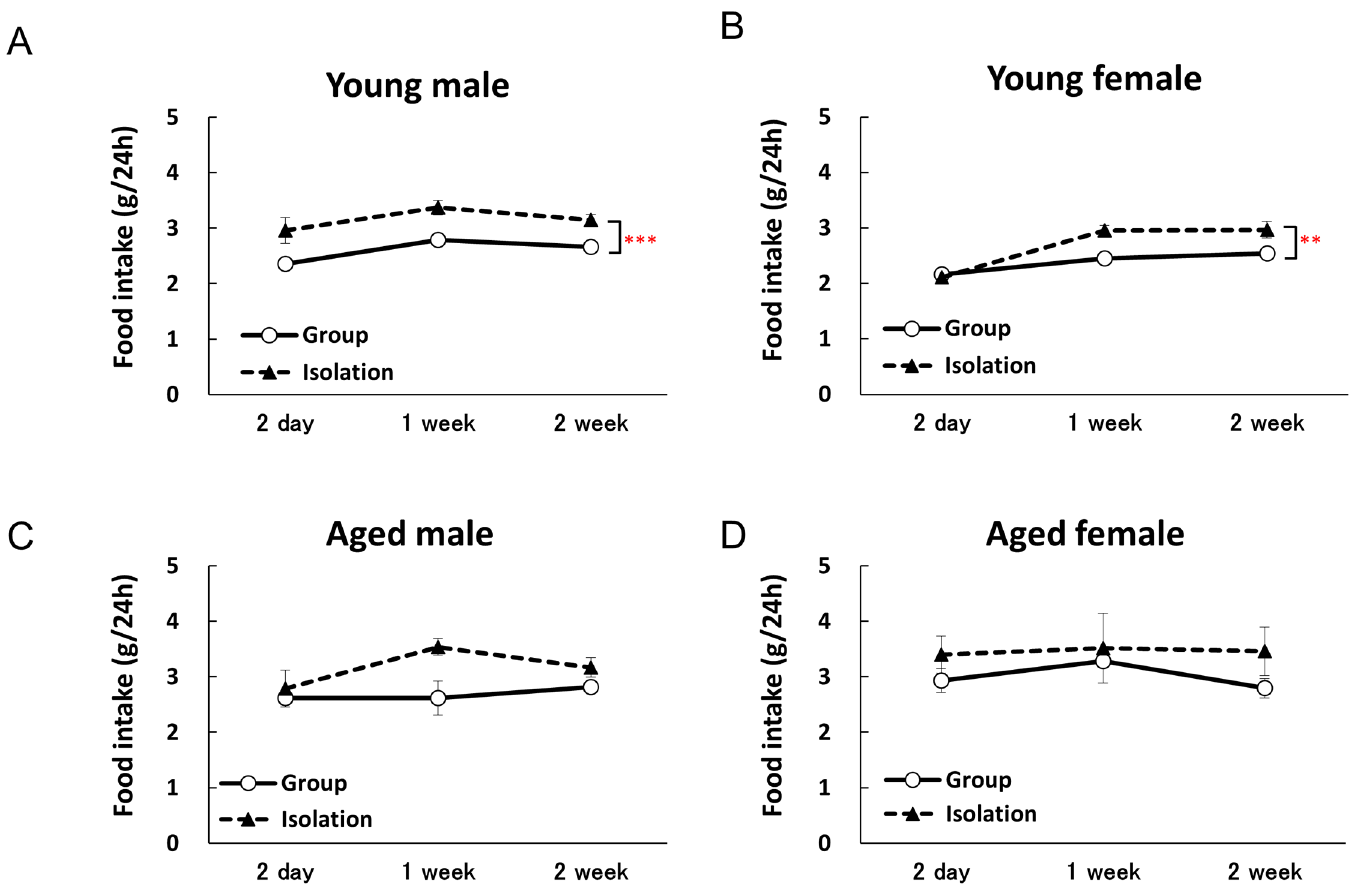
Fig 3. Food intake rates during 2 weeks of isolation. Two-way repeated measures factorial ANOVA of 24-h cumulative food intake in the young males and females detected significant effects of isolation [young male: F(1, 33) = 18.563, p < 0.001; young female: F(1, 36) = 7.9896, p < 0.01] and of time [young male: F(2, 33) = 3.6586, p < 0.05; young female: F(2, 36) = 20.315, p < 0.001], but the isolation × time interaction effects [young male: F(2, 33) = 0.0877, n.s.; young female: F(2, 36) = 2.7901, n.s.] were not significant. In aged mice, there were no significant effects of isolation [aged male: F(1, 22) = 4.1125, n.s.; aged female: F(1, 24) = 1.0384, n.s.] or of time [aged male: F(2, 22) = 1.8869, n.s.; aged female: F(2, 24) = 0.0923, n.s.], and isolation × time interaction effects [aged male: F(2, 22) = 1.1071, n.s.; aged female: F(2, 24) = 0.0793, n.s.] were not significant. The 24-h cumulative food intake rates in young male mice (A), young female mice (B), aged male mice (C), and aged female mice (D) are shown. The data represent the mean ± SEM (Young group: n = 5, Young isolation: n = 8 – 9, Aged group: n = 3, Aged isolation: n = 6 – 7). ** , *** p < 0.01, 0.001 respectively vs. group-housed